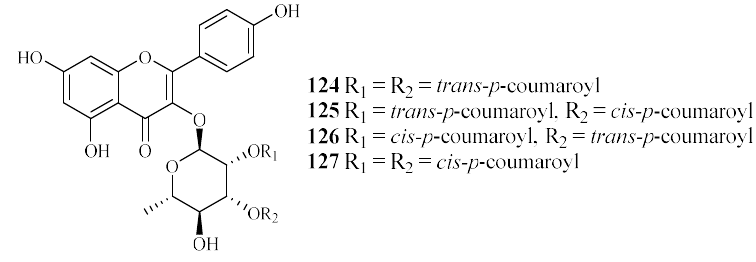
Figure 28. Compounds from a Platanaceae plant.